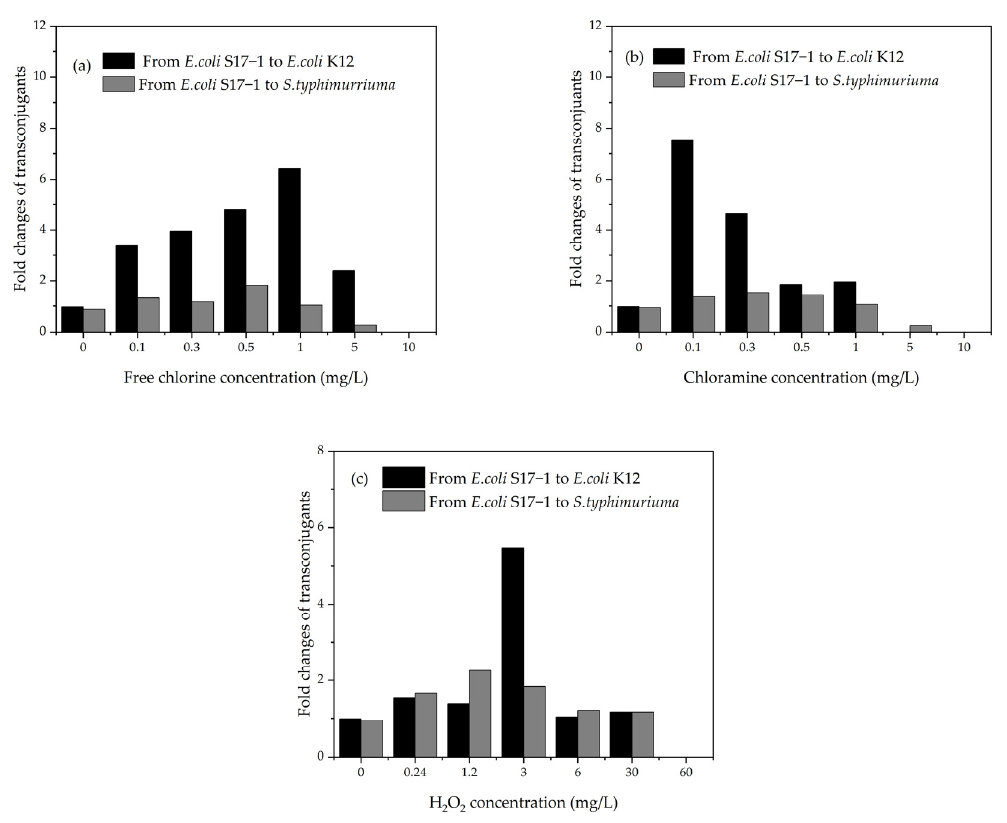
Figure 5. Effect of ( a ) free chlorine, ( b ) chloramine and ( c ) H 2 O 2 on intrageneric and transgeneric conjugation transfer [114]. conjugation transfer